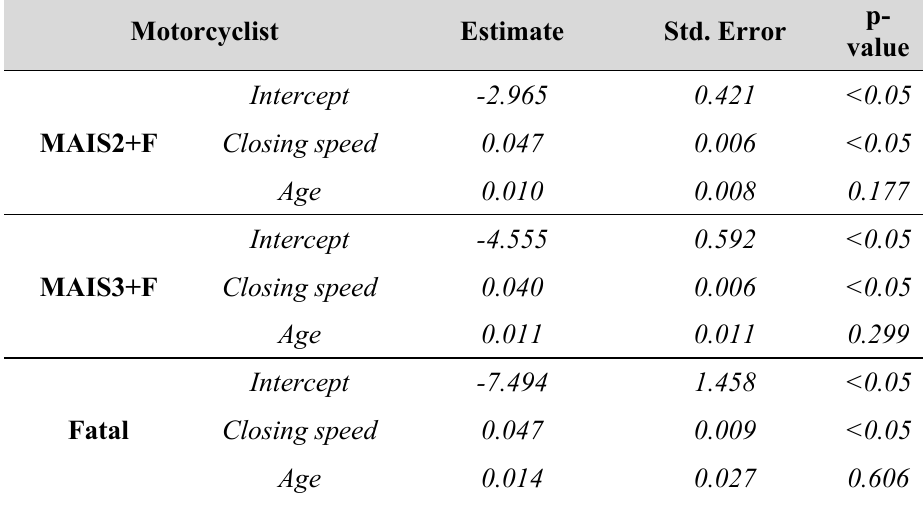
Table 4. Motorcyclist injury risk models: Logistic regression coefficient estimates according to Equation (1)